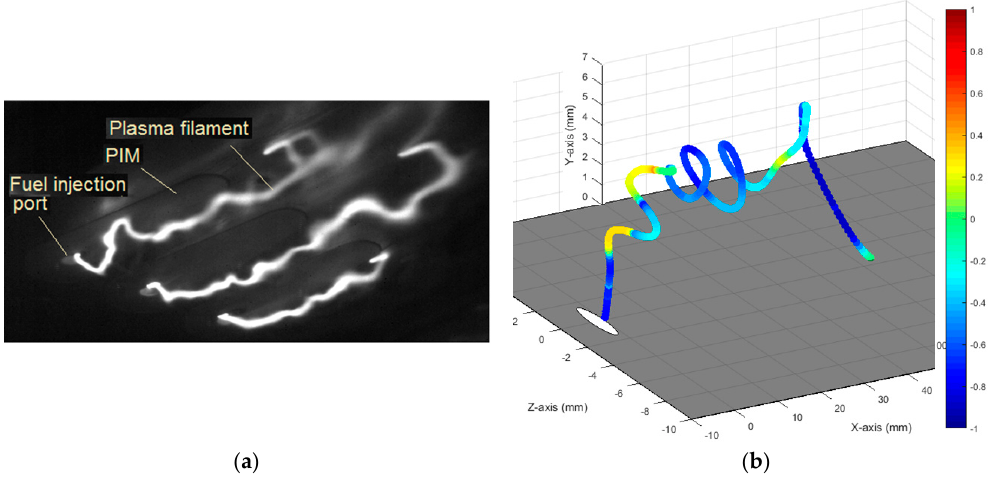
Figure 16. ( a ) FastCam frame showing the discharge morphology; ( b ) 3D reconstruction of the plasma filament shape. Reprinted from [110] with permission from authors.